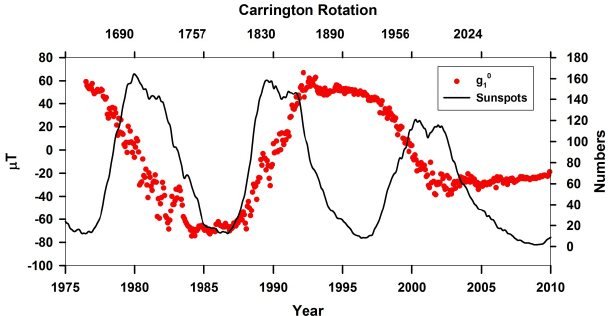
Figure 1. A plot showing the axial dipolar spherical harmonic solar magnetic field g 0 coefficient as well as the smoothed monthly mean 1 sunspot numbers between 1975 and 2010, and Carrington rotations